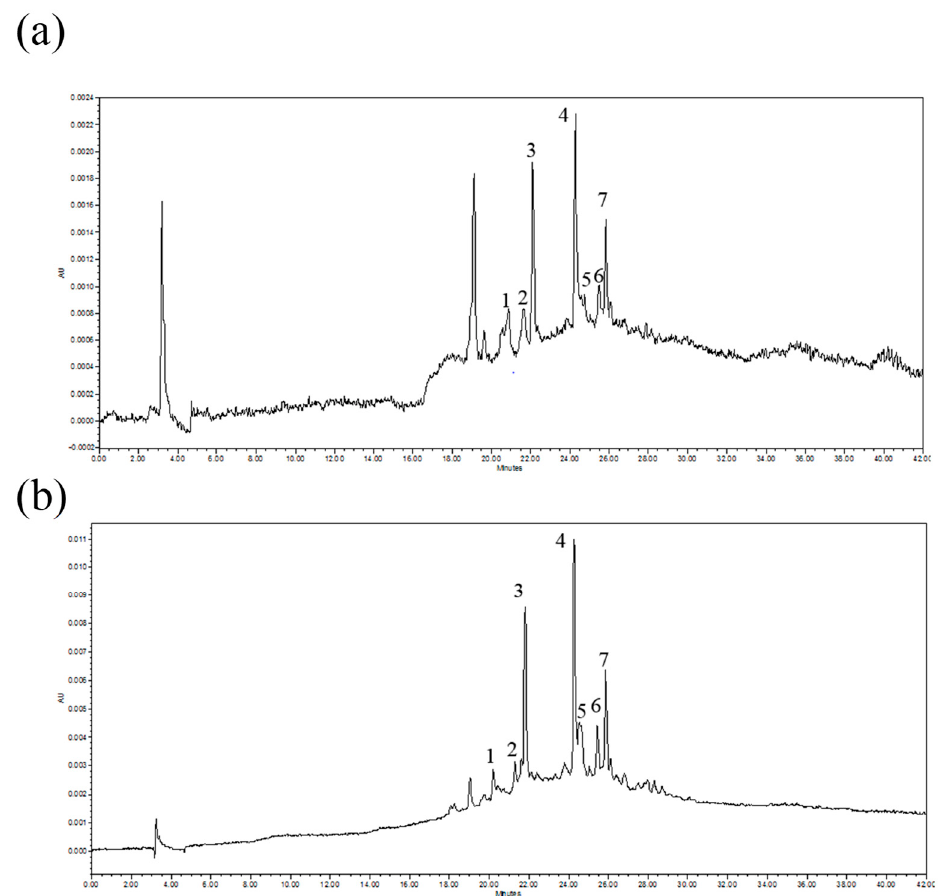
Figure 1. HPLC profiles at λ = 340 nm of the extract obtained using microwave (MW) and sub-critical H 2 O ( a ) before and ( b ) after solid phase extraction (SPE). Peaks on the chromatogram correspond to: 1, chlorogenic acid; 2, p -hydroxybenzoic acid; 3, caffeic acid; 4, luteolin-3-glucoside; 5, p -coumaric acid; 6, chicoric acid; 7, apigenin-3-glucoside.